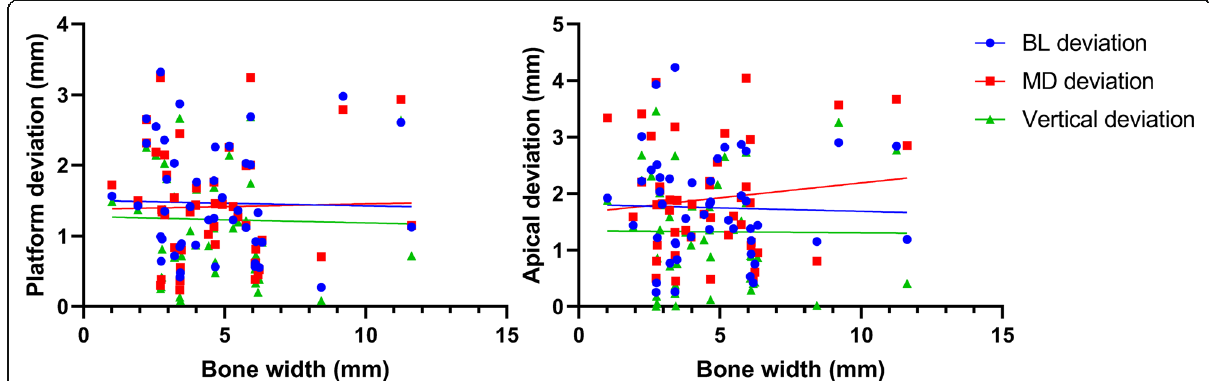
Fig. 6 Scatter plot showing a linear correlation between bone width and implant deviation. Left: deviation at the implant platform; right: deviation at the implant apical